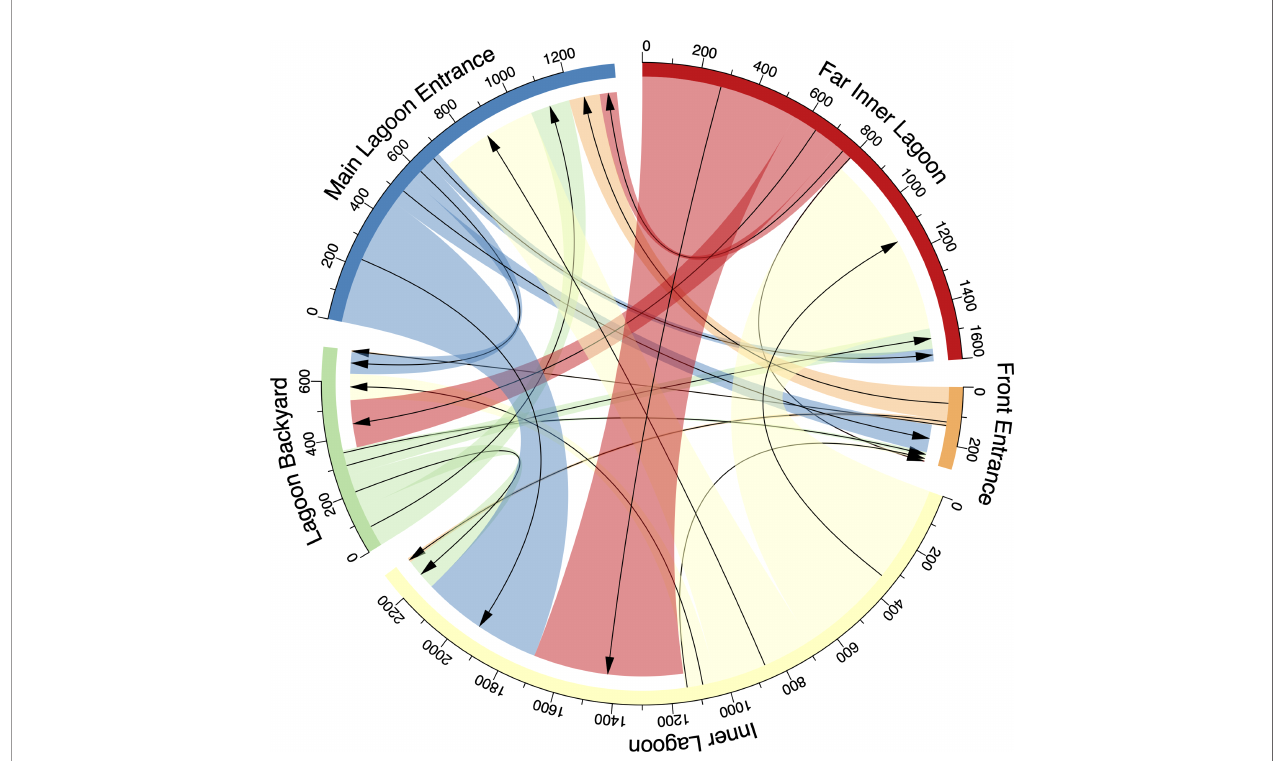
FIGURE 7 | Connectivity plot presenting the number of movements of acoustically tagged juvenile M. alfredi between receivers in the Wayag lagoon. The arrows show the direction of movement from one receiver to another, and the colour-coded receiver location names are outside the